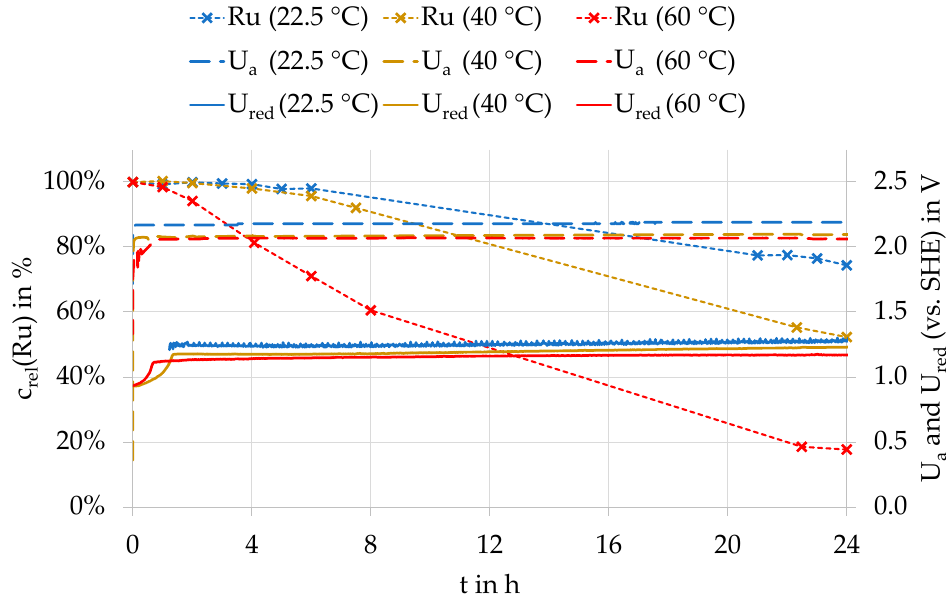
Figure 4. Relative ruthenium concentration (c rel (Ru)), anodic potential (U a ), and redox potential (U red ) at different temperatures during an electrolysis with a PbSnCa anode at 40 °C. At higher temperatures, the anode potential increases faster at the start of electrolysis.